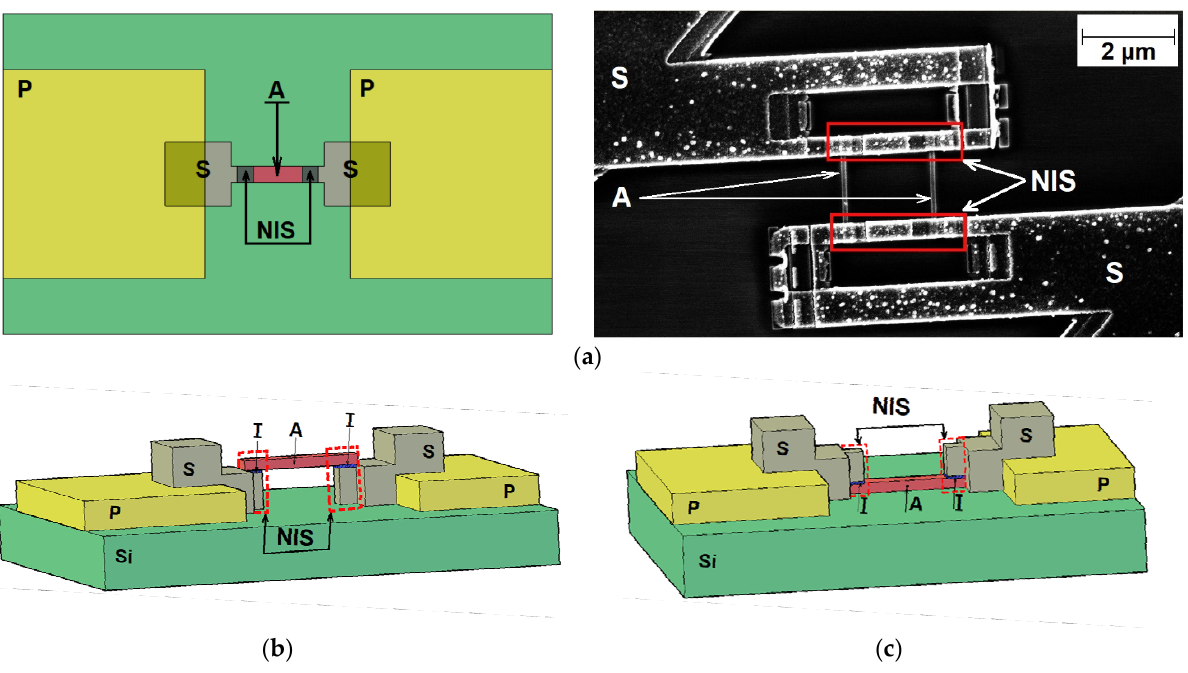
Figure 4. SINIS detector: ( a ) top view, schematic image ( left ) and SEM photo ( right ); ( b ) schematic image of SINIS detector with suspended absorber; ( c ) schematic image of SINIS detector with absorber on substrate. S—superconductor, I—insulator, A—absorber (normal metal), P—pads (supply electrodes).